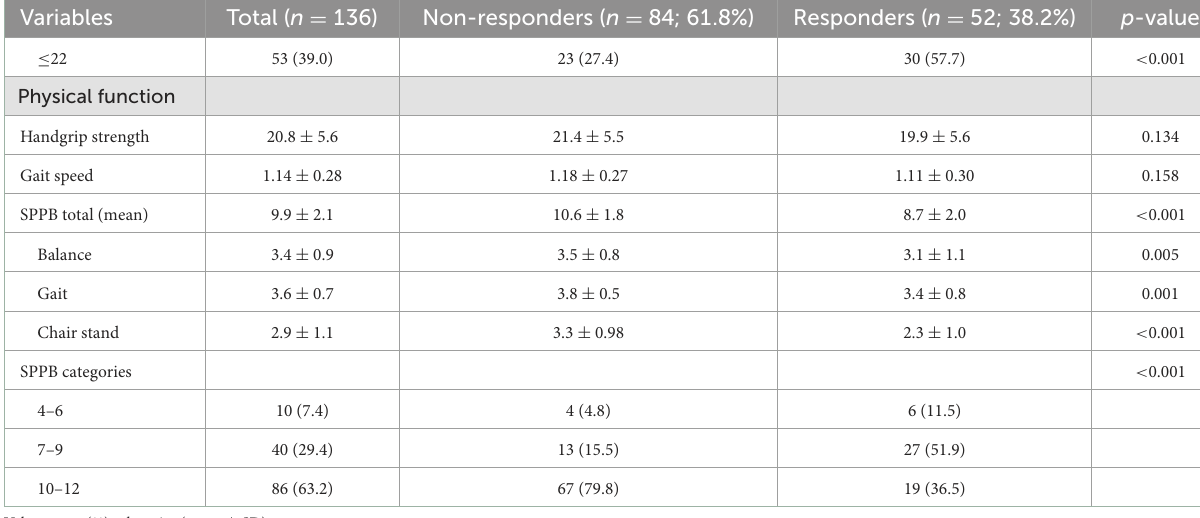
TABLE 4 Prediction model for responders and weightage scores.